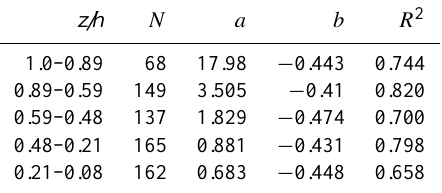
Table 2. The simulated power function | φ m | = a | Ri | b with lo- cal | Ri | > 1 in different layers within the canopy during nighttime, where φ m is the local flux-profile relationship of wind speed, Ri is the local bulk Richardson number, and a and b are